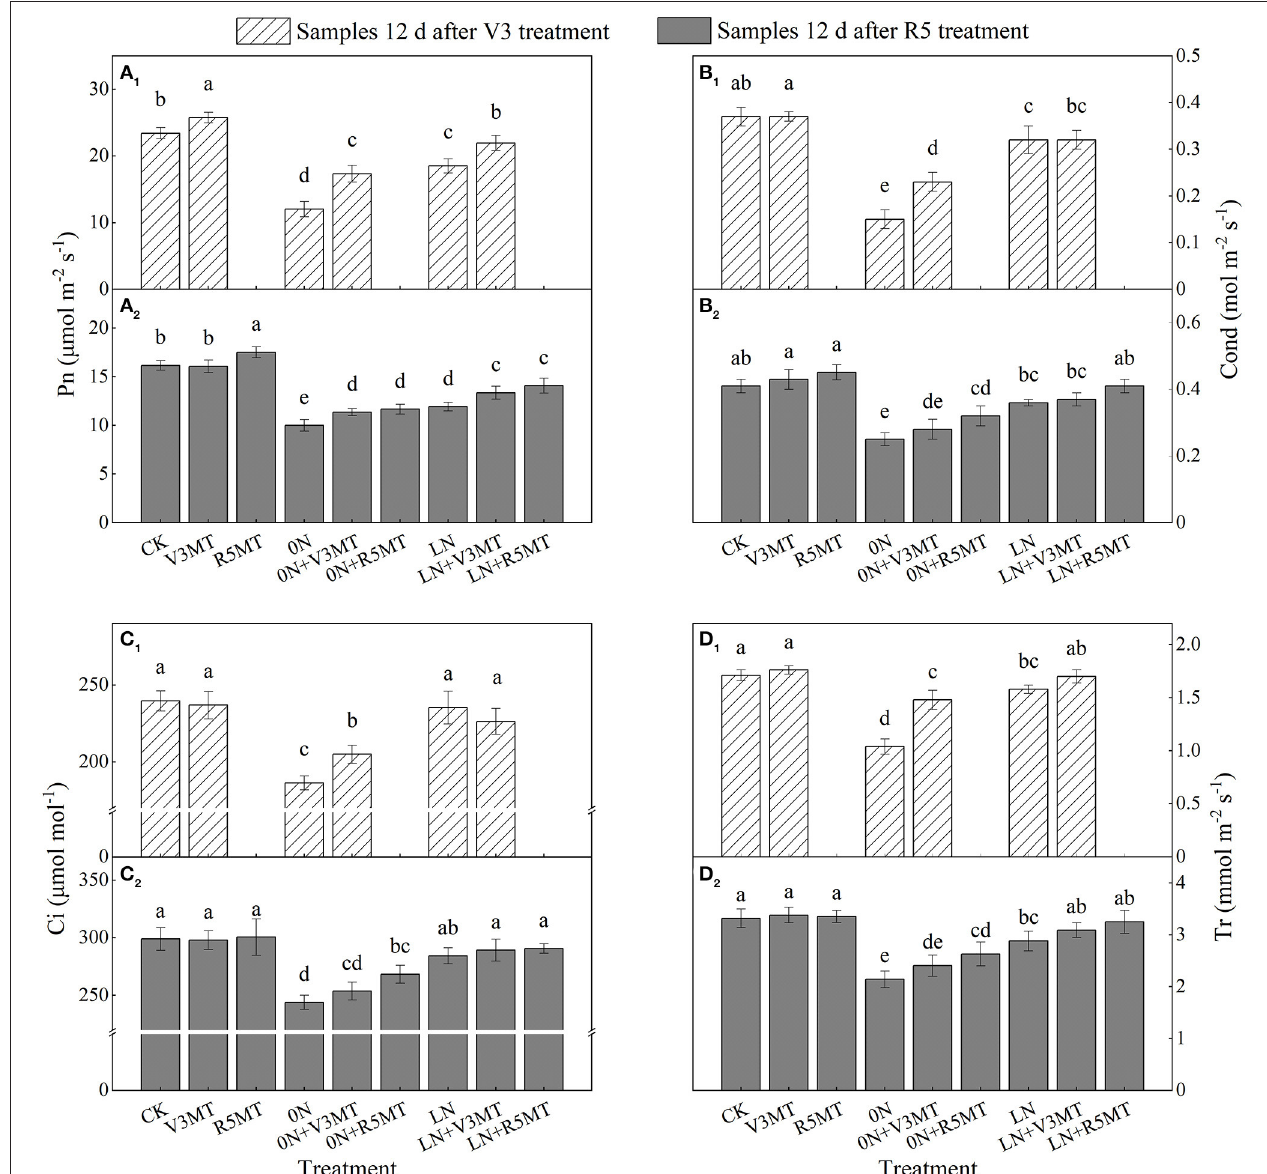
FIGURE 10 | The effect of exogenous melatonin (V3 and R5) on the net photosynthetic rate (Pn, A ), stomatal conductance (cond, B ), intercellular carbon dioxide concentration (Ci, C ), and transpiration rate (Tr, D ) in plant leaves under three N levels. The abbreviated meaning of each treatment is the same as in Figure 3 . The values were presented as mean ± SE ( n = 3). Different letters in one measuring group indicate statistically significant differences when P ≤